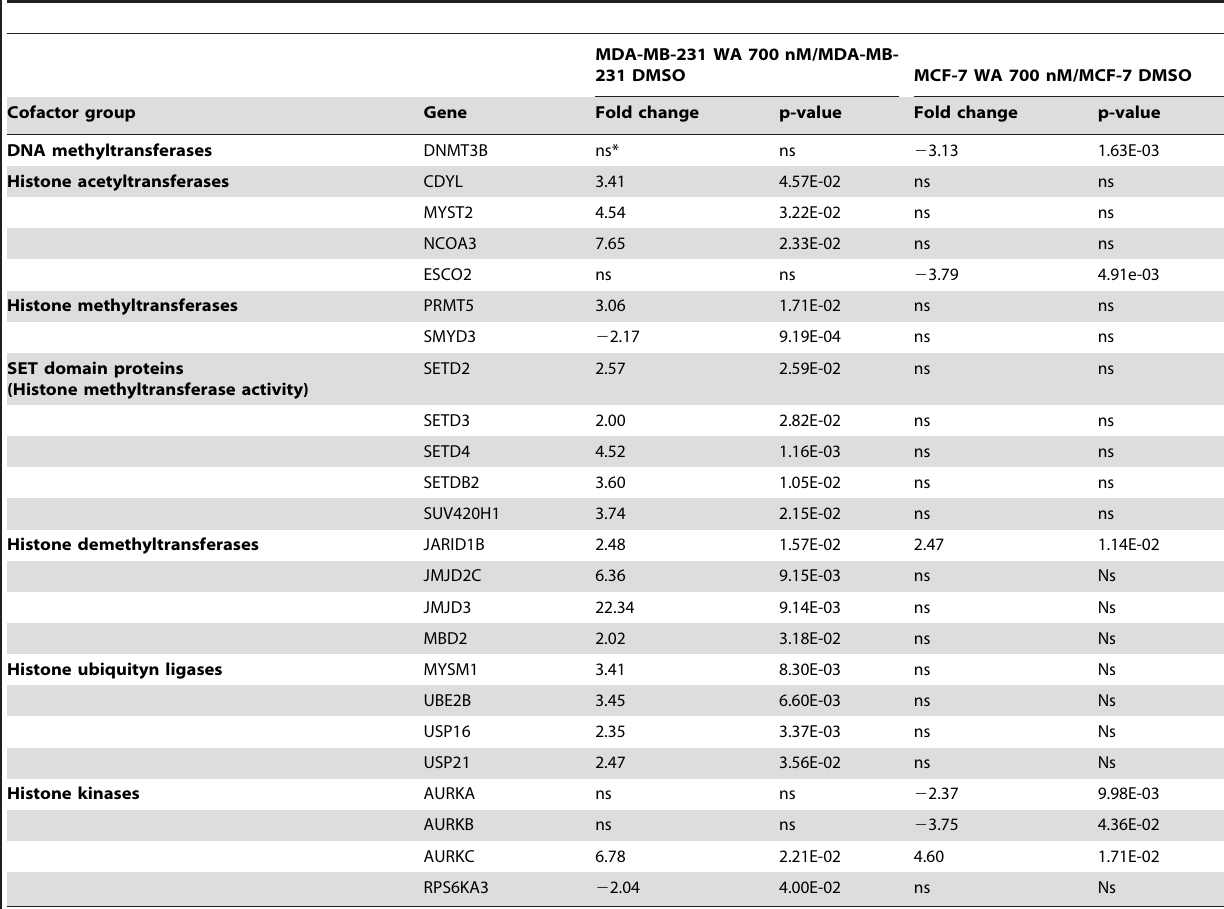
Table 3. Significantly differently expressed chromatin and DNA modifying enzymes as determined by Human Epigenetic Chromatin Modification Enzyme qPCR